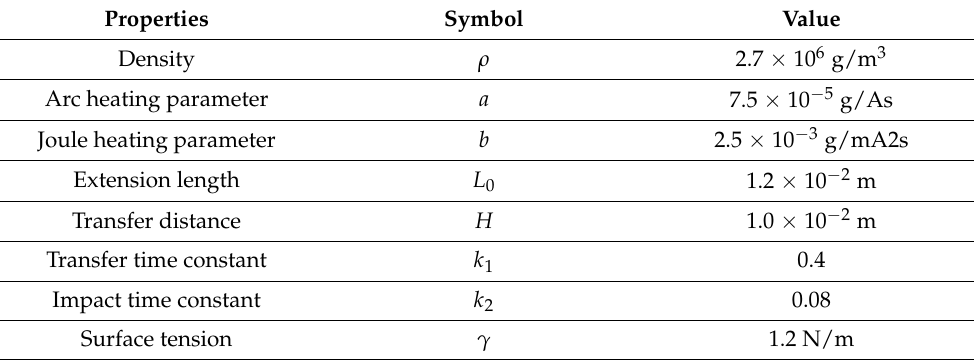
Figure 4. Simplified controlled driving and spreading process of the molten pool. ( a ) Wire feed: arc pressure; ( b ) Wire withdrawal: droplet impact; ( c ) Wire withdrawal: residual energy transfer. Table 2. Physical and material properties used for analysis.